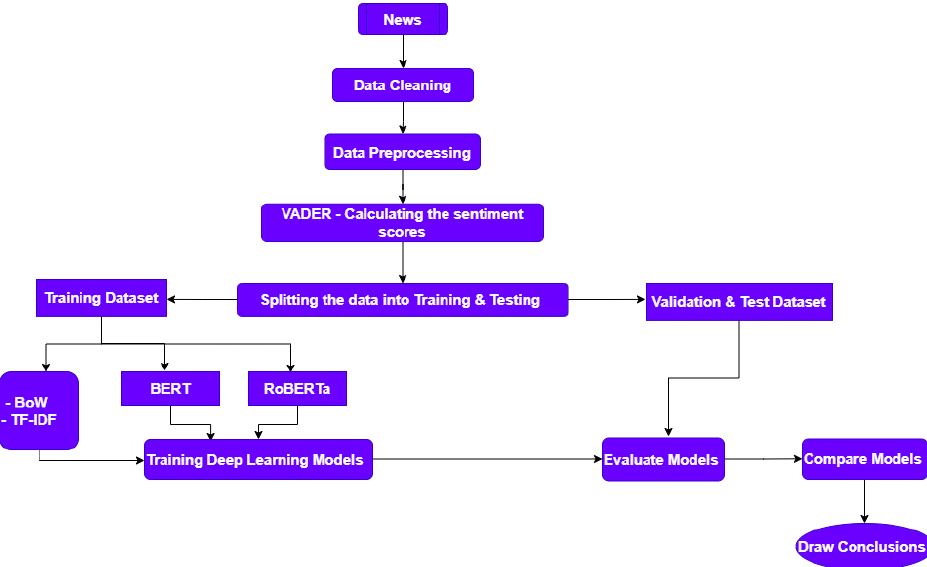
Figure 1. An overview of the workflow of the proposed framework.